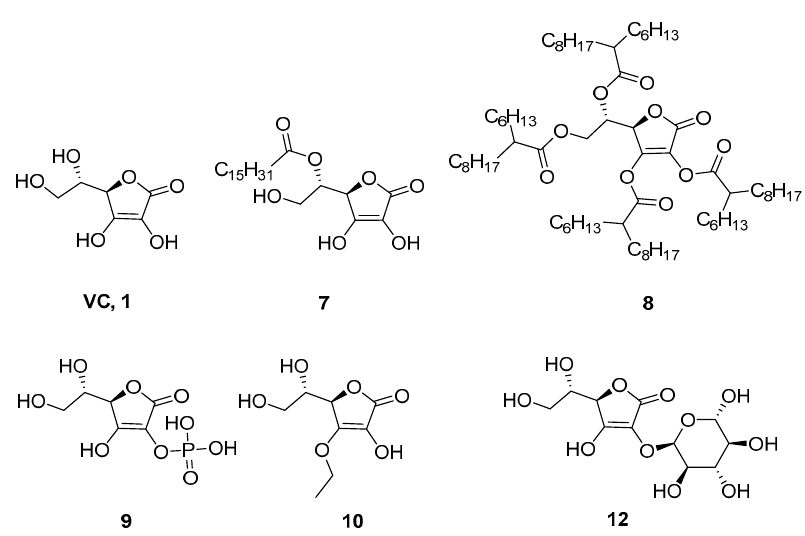
Figure 1. Structures of vitamin C ( VC , 1 ), acylated derivatives ( 7 – 9 ), and alkylated derivatives ( 10 , 12 ).